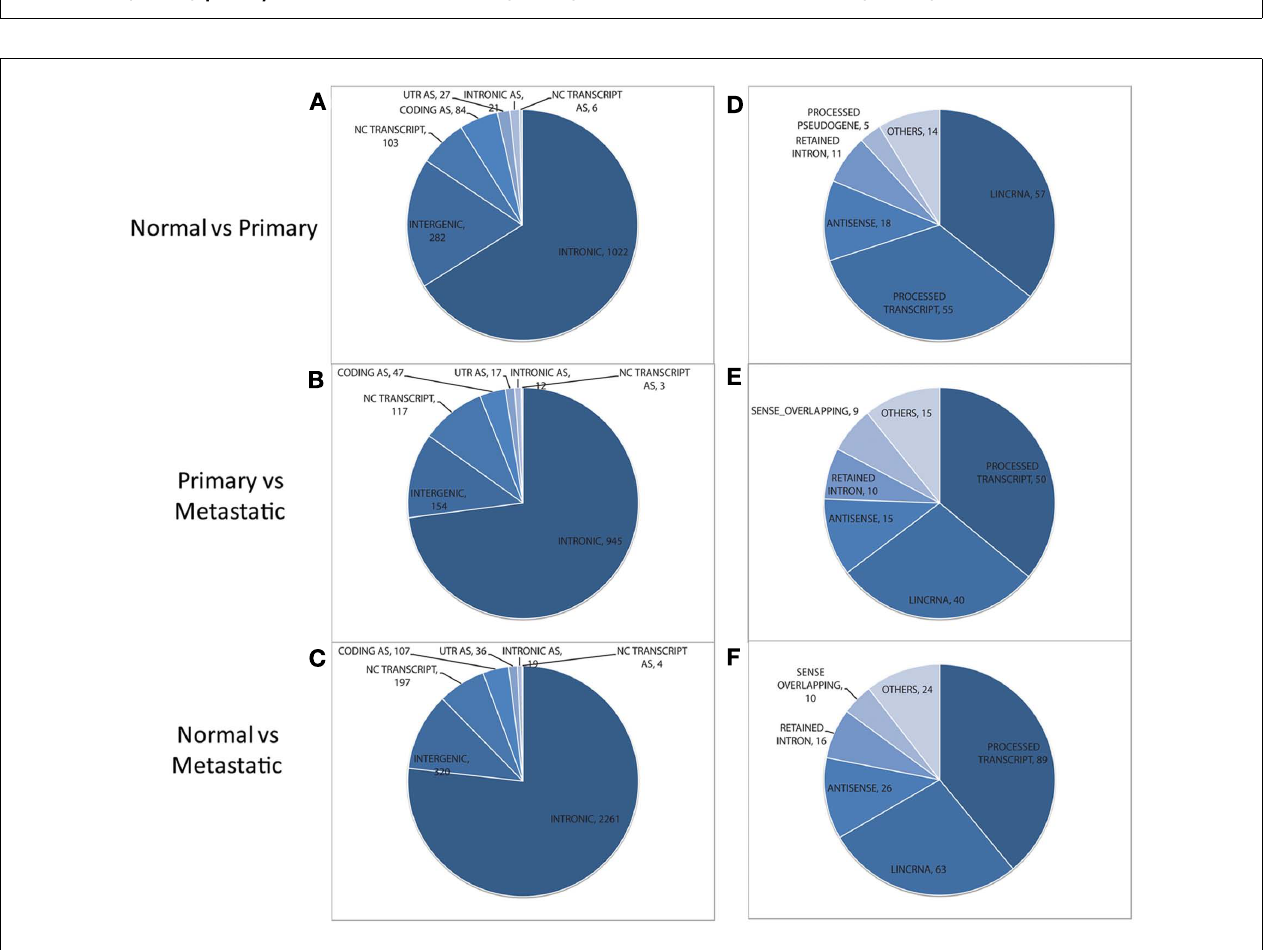
FIGURE 2 | Distribution of non-exonic features (left) and overlapping annotated non-coding transcripts (right) found to be differentially expressed between normal and primary tumor (A,D), primary tumor and metastatic tissue (B,E), and normal vs. metastatic tissue (C,F).